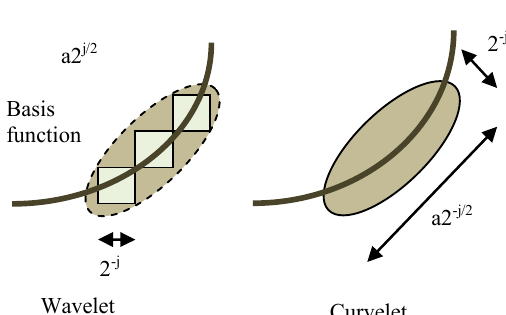
Fig. 3: Non-linear approximation of a 2-D piecewise smooth signals (Do and Vetterli 2002) Curvelets partition the frequency plane into dyadic coronae and (unlike wavelets) sub-partition those into angular wedges which again display the parabolic aspect ratio. Hence, the curvelet transform refines the scale-space viewpoint by adding an extra factor, orientation, and operates by measuring information about an object at specified scales and locations but only along specified orientations.